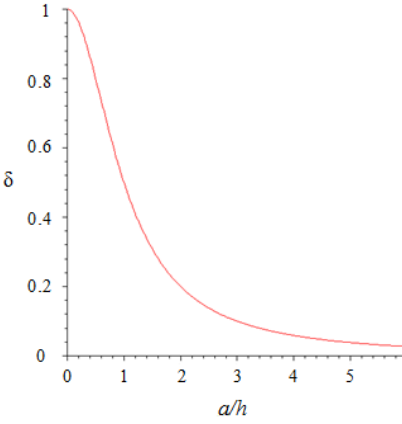
Figure 6. The proportionality coefficient δ between normal stress T 3 on the sensor and overall contact force F 3 (see Equation (12)) is plotted versus the imprint radius a (contact size) scaled by the elastomer thickness h (see Figure 5 for notations). Note that the point-like sensor is aligned with the contact center.